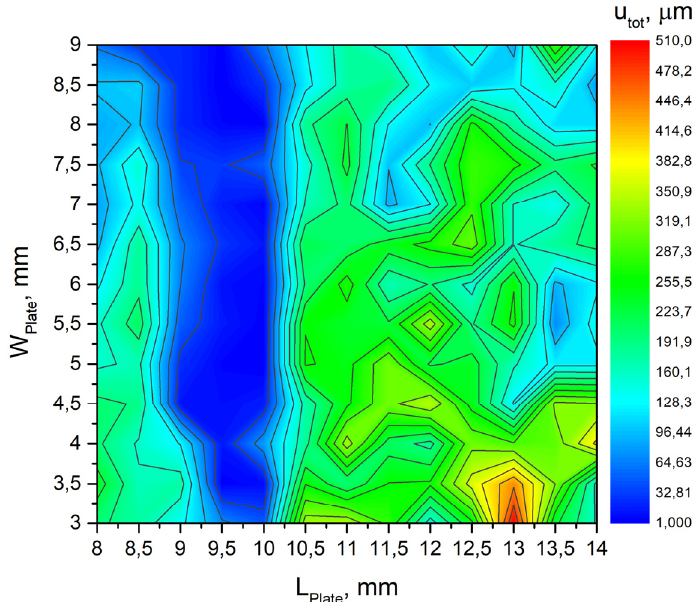
Figure 4. The plot of the objective function.